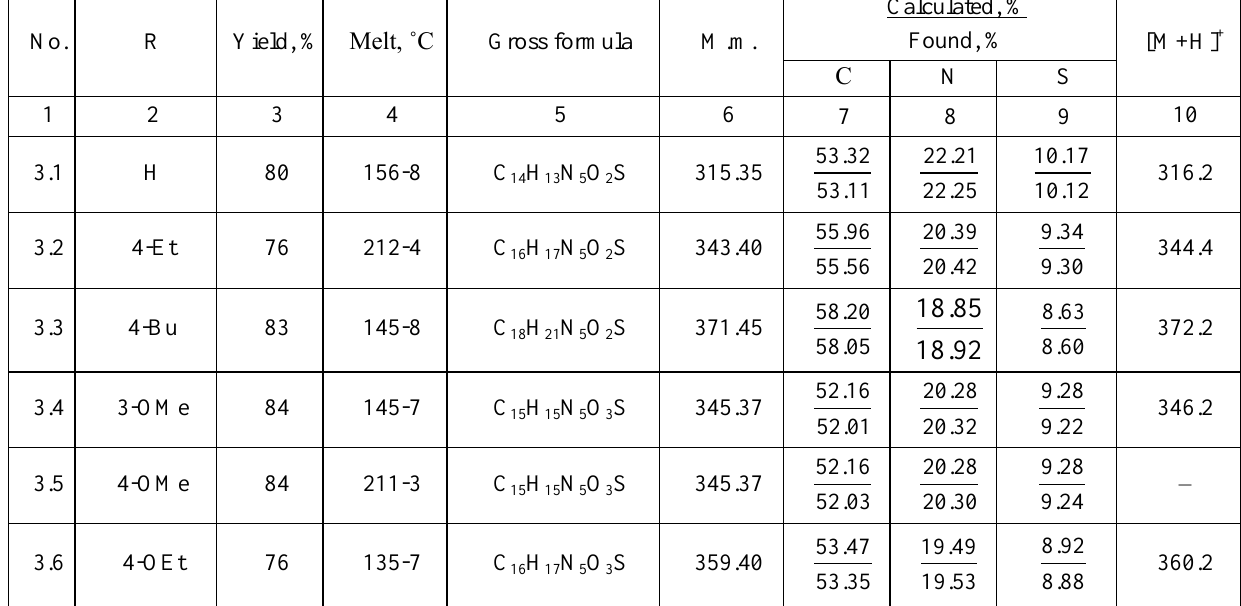
Physicochemical characteristics of synthesized 2-((4-amino-5-(furan-2-yl)-1,2,4-triazolo (4H) -3-yl) -sulfanyl)- N-acetamides ( 3.1–3.21